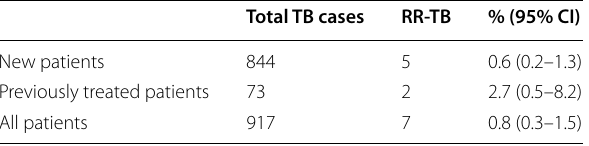
RR-TB rifampicin resistant tuberculosis, 95% CI 95% confidence